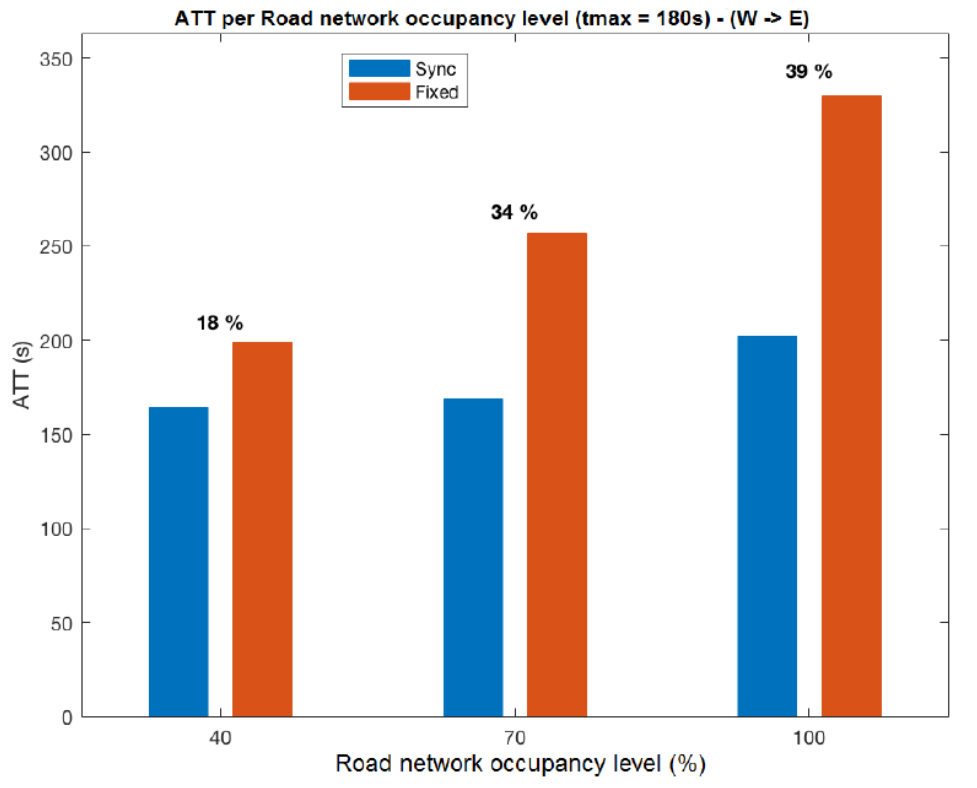
Figure 15. Impact of road network occupancy on the achieved